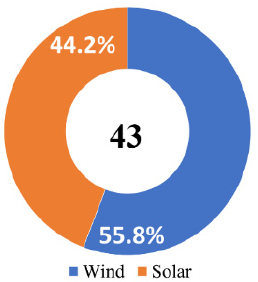
Figure 10. Occurrence of “wind” and “solar” references in most frequent words (ROI ).